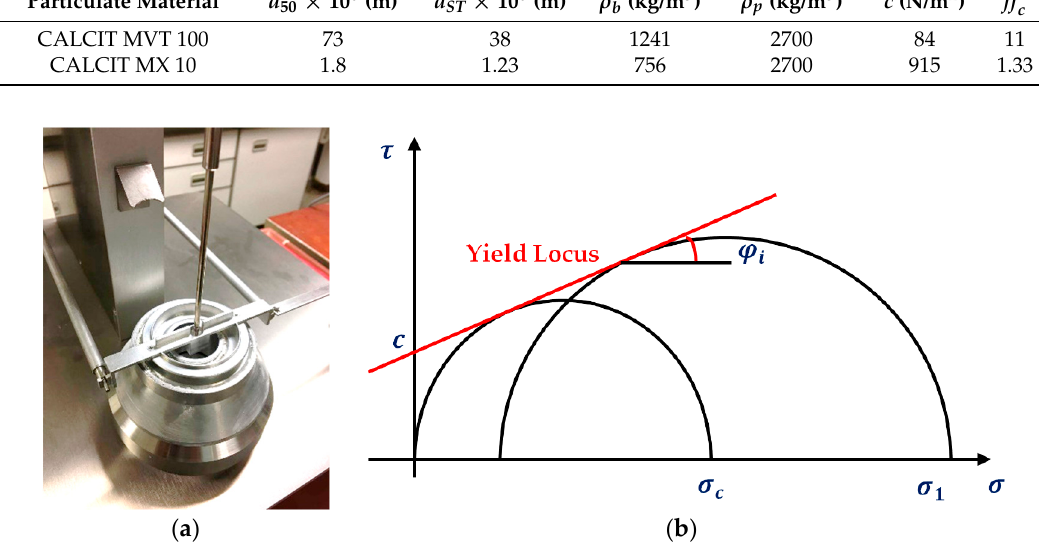
Figure 2. ( a ) Ring shear cell, ( b ) Yield locus line.